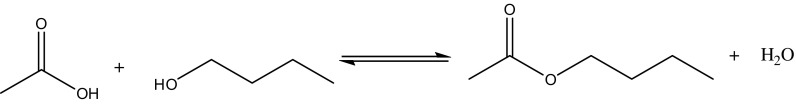
Synthesis of butyl acetate.